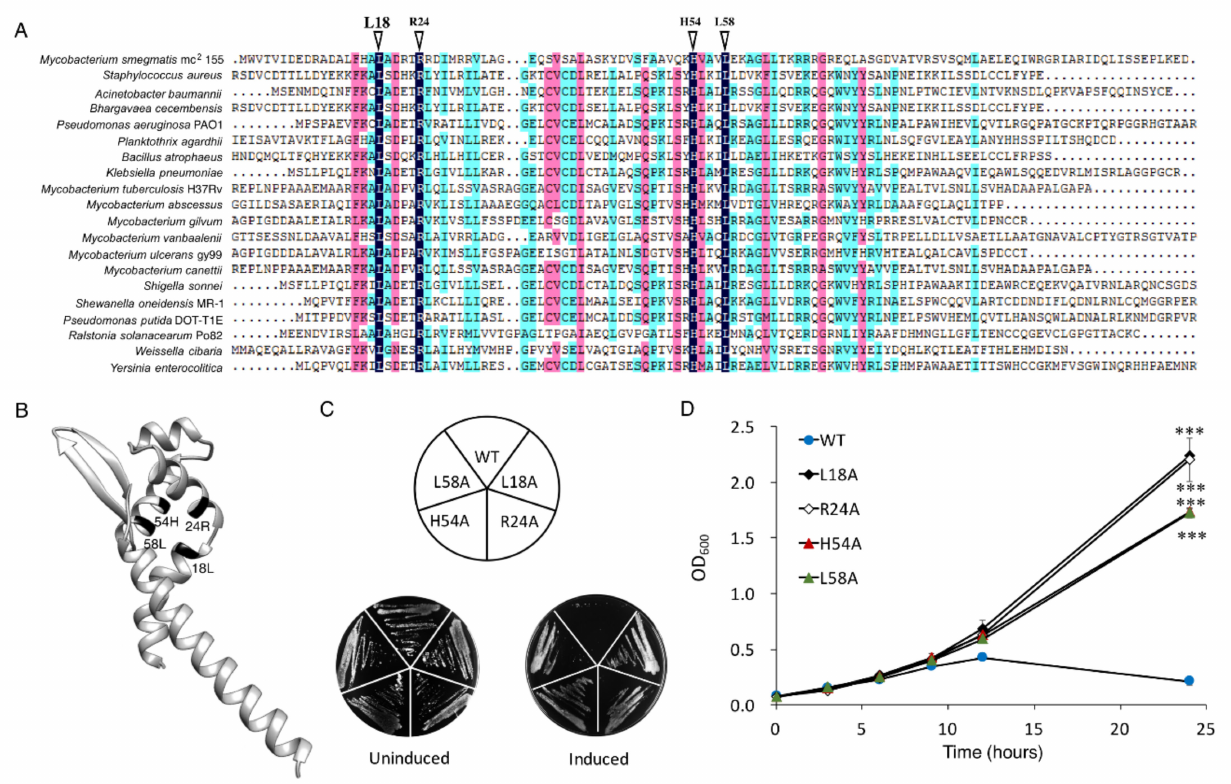
Figure 2. Key residues for MSMEG_6762 toxicity. ( A ) Conserved amino acid residues of MSMEG_6762 . ( B ) Predicted 3D structure of MSMEG_6762 . Toxicity results of single-site